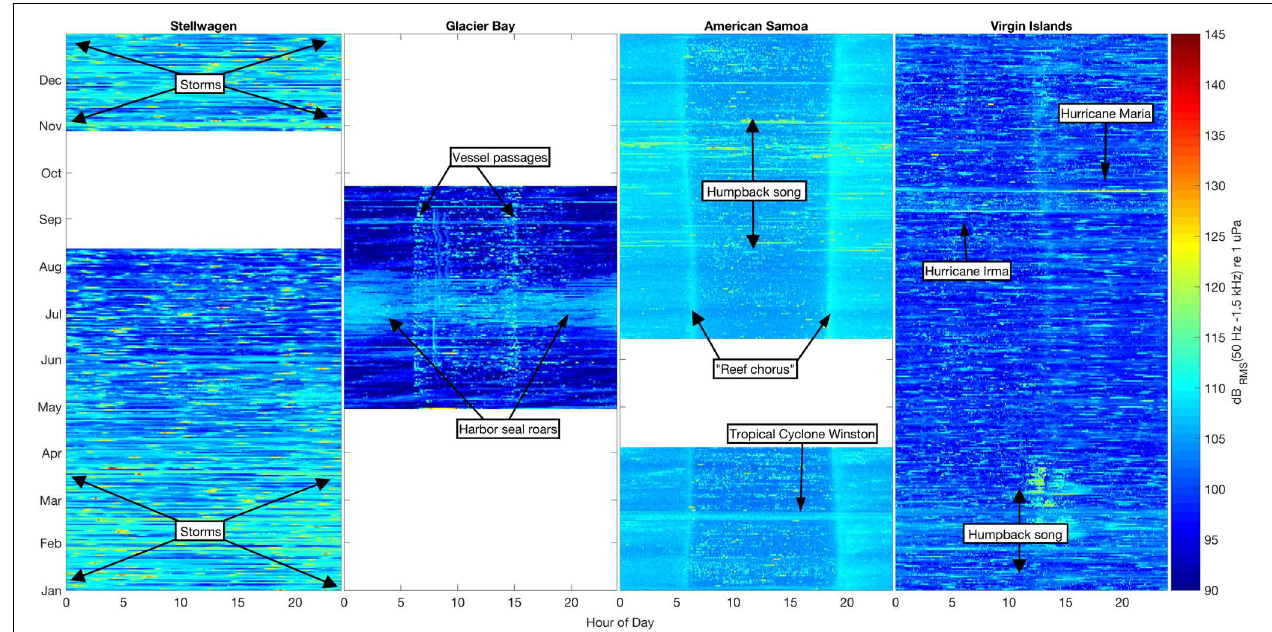
FIGURE 3 | Sound levels in the 50 Hz–1.5 kHz band (dB RMS re 1 µ Pa) at four shallow-water mooring sites calculated in 5-min bins for all available data. Color (blue–yellow–red) indicates sound level intensity in each bin, with the lowest levels (90 dB) dark blue and the highest (145 dB) bright red. Each NRS site is plotted by month (January–December) and hour of day